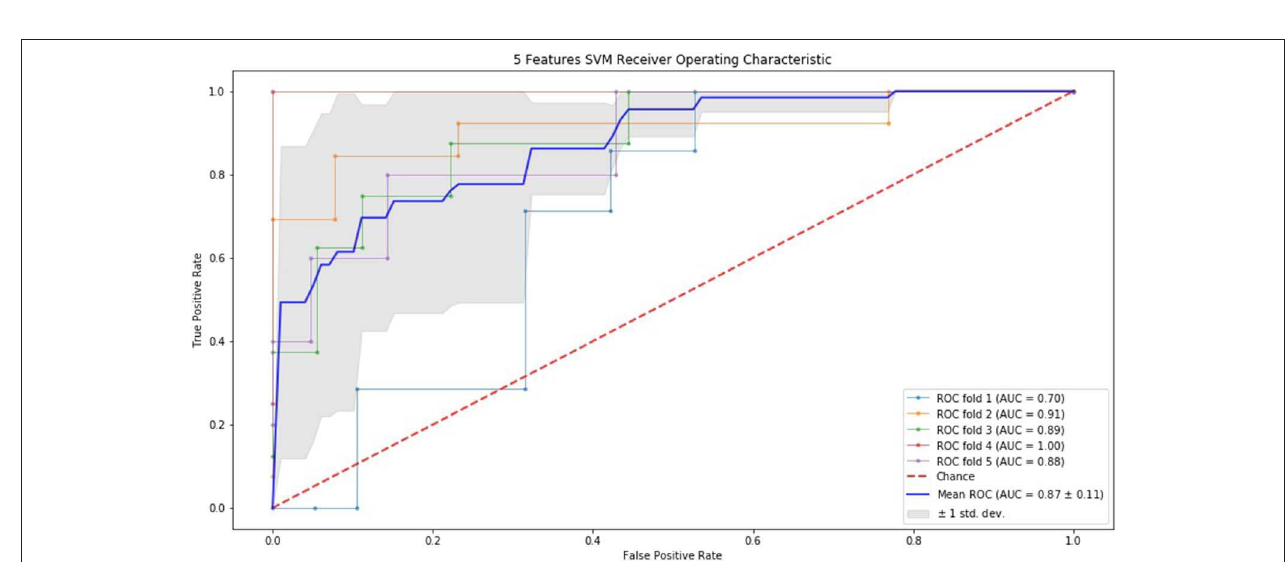
FIGURE 1 | ROC of 5-fold cross validation results of SVM. The mean AUC of 3 feature model was 0.85 ± 0.10.